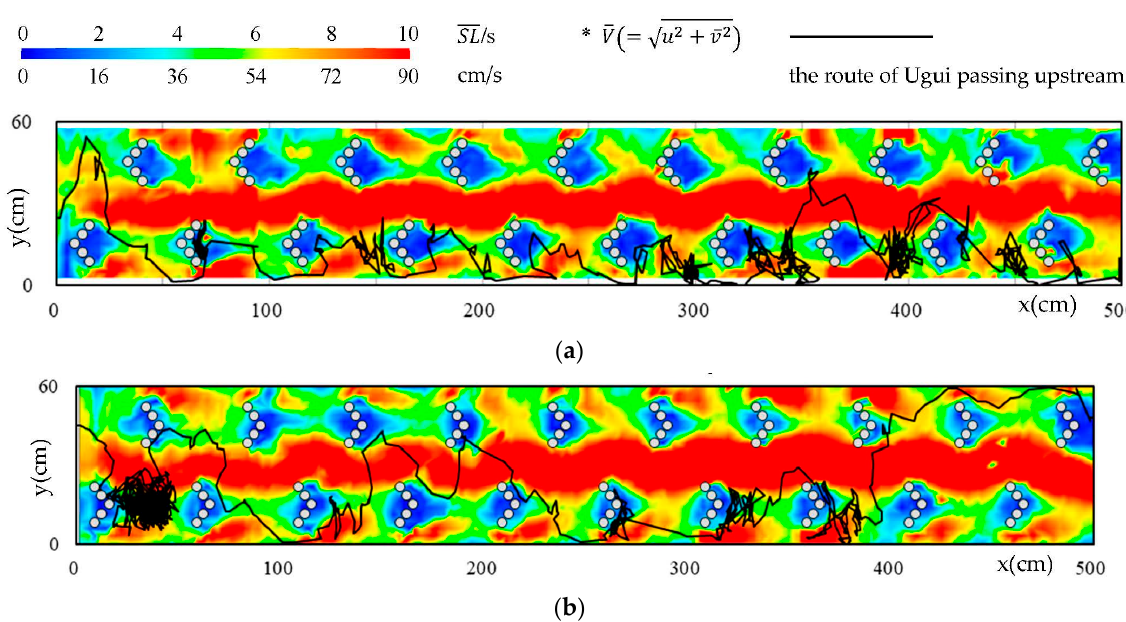
Figure 9. Flow velocity contour diagram of the fishway and the route of Ugui passing upstream in each case of this study: ( a ) Run5-cu in Case 5; ( b ) Run5-cd in Case 5.